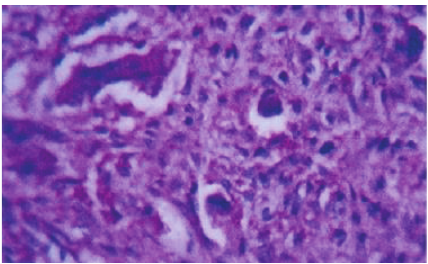
Figure 4: Histopathological section showing multinucleated giant cells resembling osteoclasts, scattered in a fibrous connective tissue